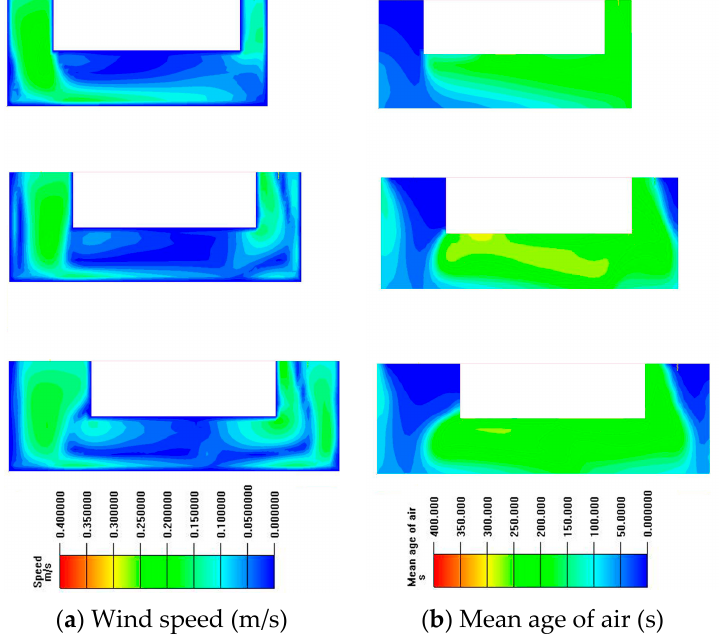
Figure 7. Comparison of different length of living room. ( a ) Wind speed; ( b ) Mean age of air.